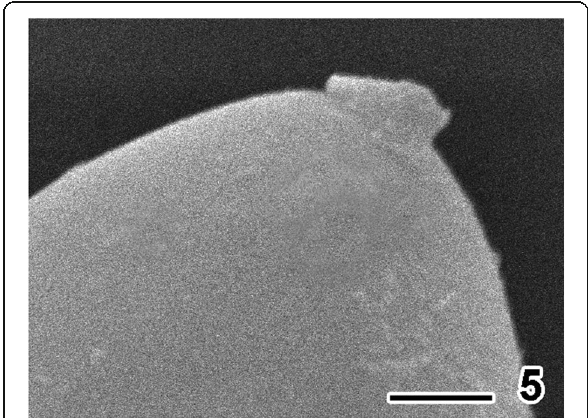
Fig. 5 Oocysts of Mattesia dispora , SEM. Note the protruding polar plug in some oocysts. Bars, 1 μ